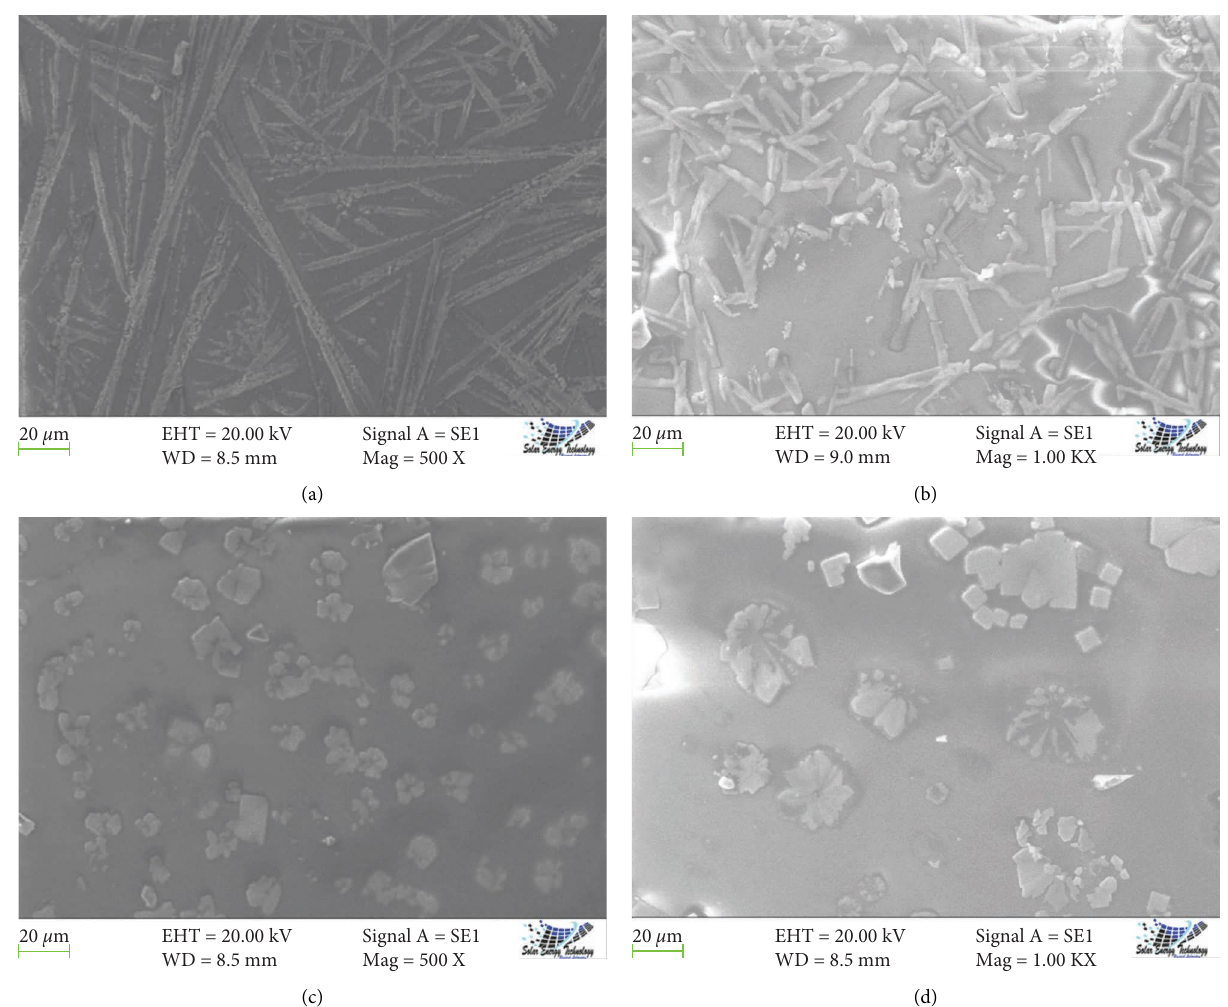
Figure 5: SEM morphological structure of (a) MAPI